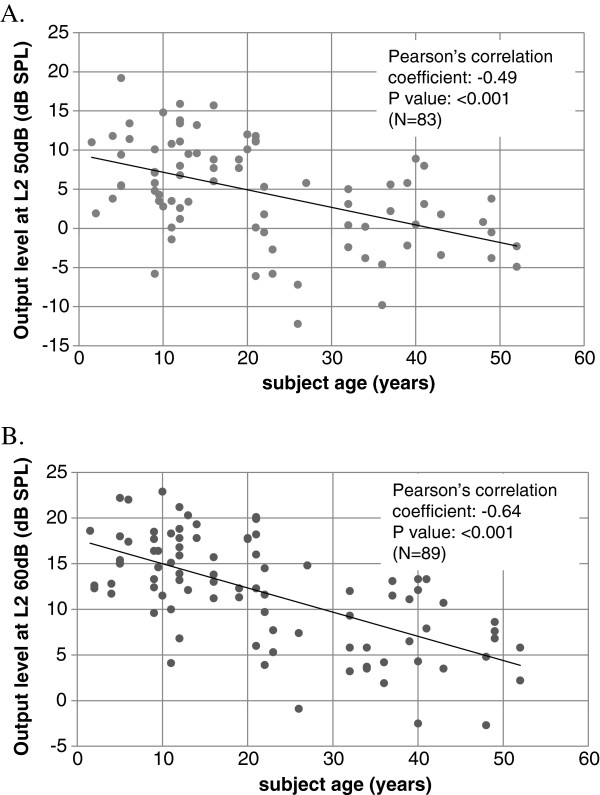
DPOAE (2f1-f2) amplitude as a function of age. In the upper plot (A) stimulus level L2 = 50 dB SPL. In lower graph (B) stimulus L2 = 60 dB SPL. Pearson’s correlation coefficients and statistical significance values are indicated.